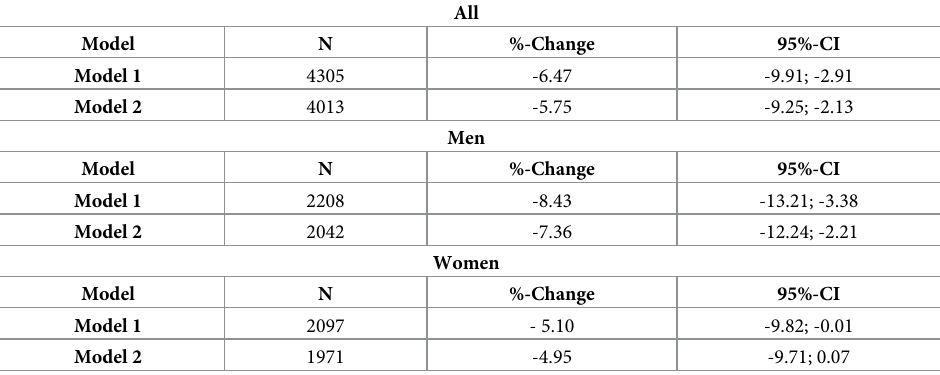
Table 2. Effect size estimates as percentage change in NT-proBNP per 1000 € income/month and 95% confidence intervals (95%-CI) for the main analysis population and stratified by